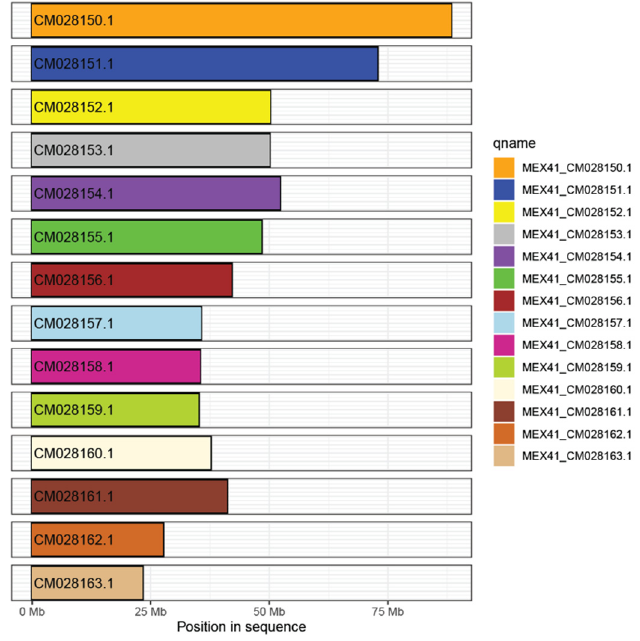
Figure 5. Genome coverage results of MEX41 on the reference genome. Fully colored chromosomes show complete coverage.